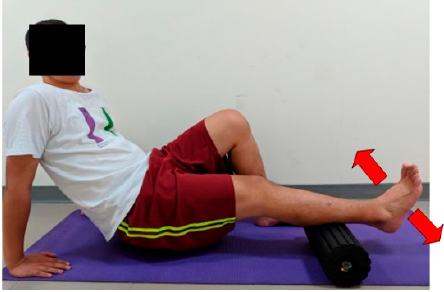
Figure 3. Vibration rolling combined with dynamic muscle contraction on the ankle joint.